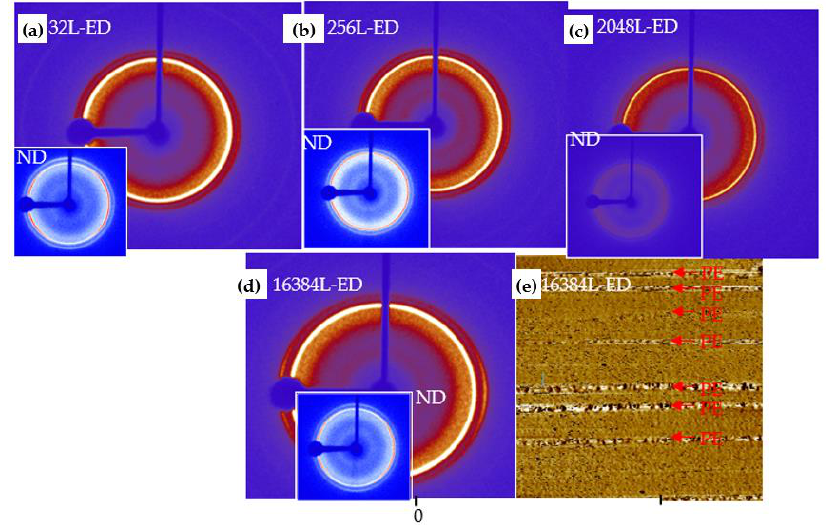
Figure A3. 2D-WAXS profiles recorded with an X-ray beam in normal and parallel directions to the film plane for LDPE/PS multilayers: ( a ) 32L, ( b ) 256L, ( c ) 2048L, ( d ) 16380L and ( e ) example of an AFM image for a sample with 16380 layers.